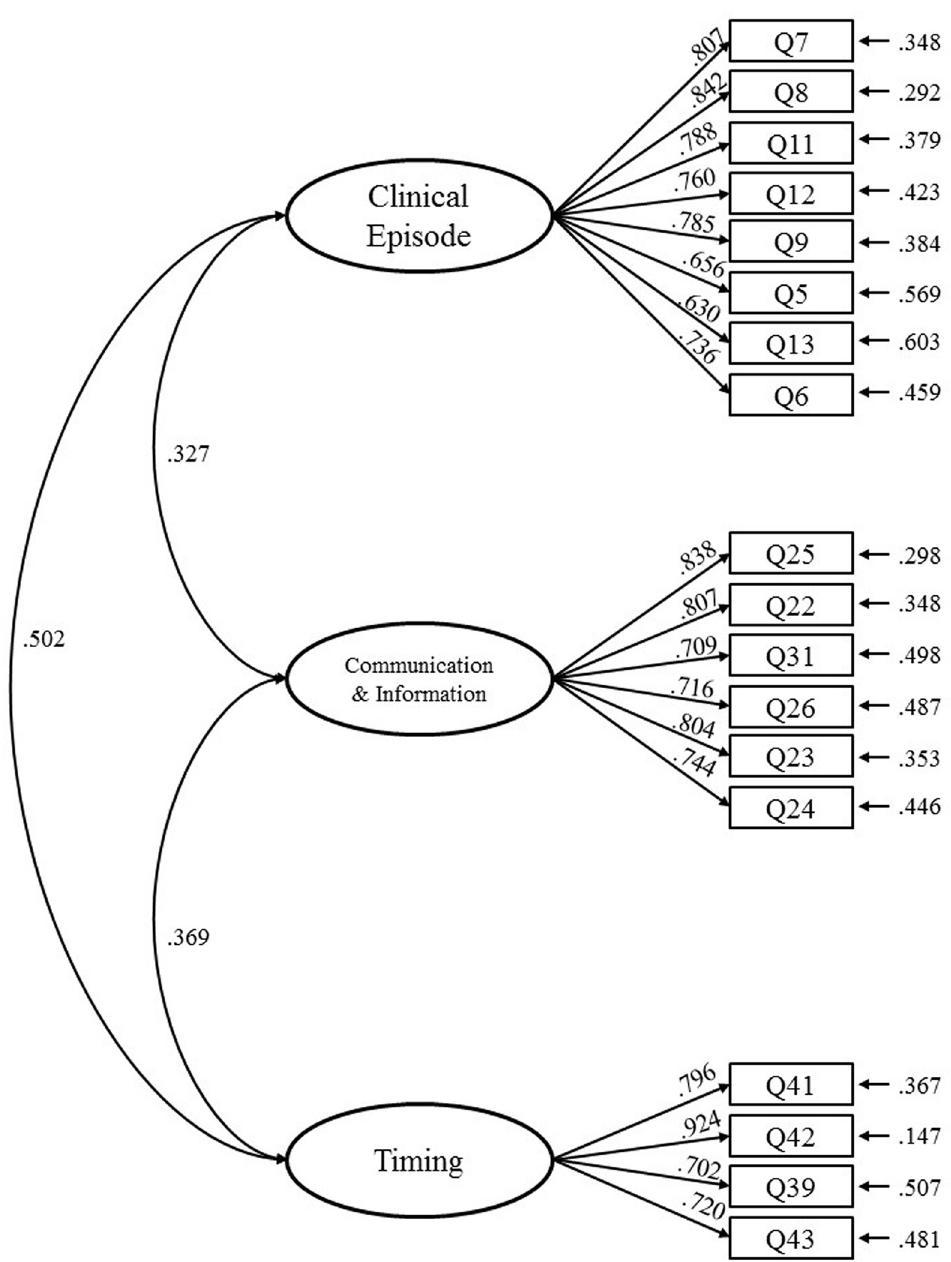
Fig 2. The PTDDS measurement model of confirmatory factor